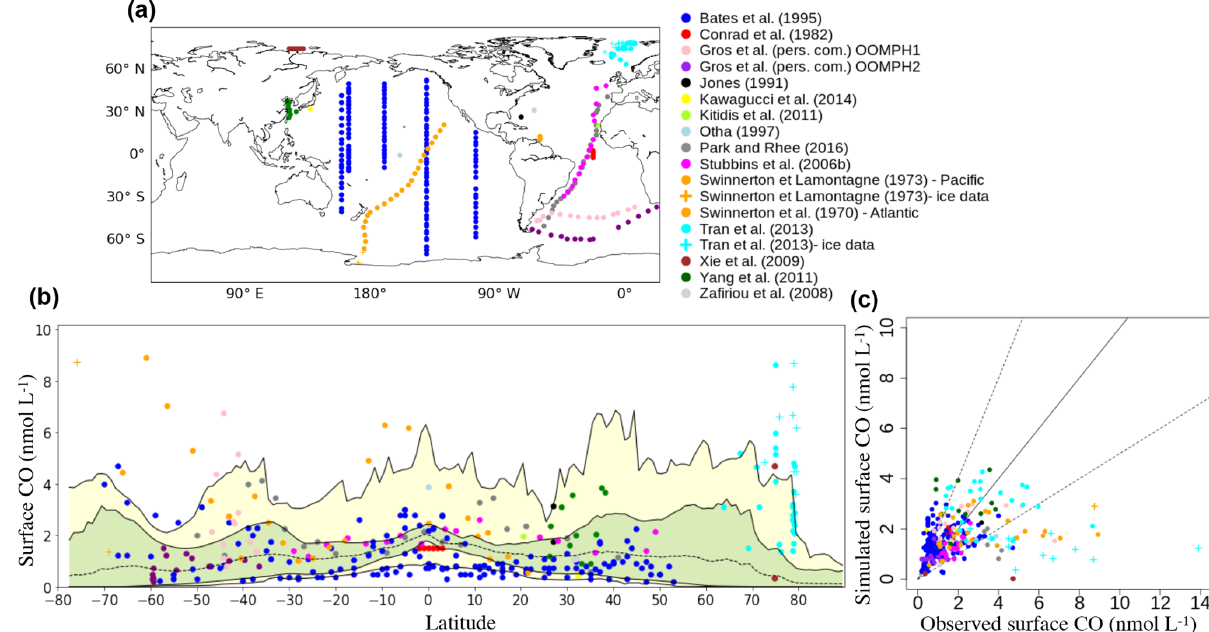
Figure 6. Comparison of in situ oceanic CO concentrations between 0 and 10m simulated with PISCES with those measured in the surface ocean. (a) Position of the surface measurements collected in the literature. (b) Surface CO concentrations as a function of the latitude (Dots: observed concentrations; dotted line: longitudinal and monthly mean simulated CO concentration; green area: interval between maximum and minimum longitudinal mean concentrations; yellow area: interval between maximum and minimum CO concentrations at a given latitude). Note that a data point of 13.9nmolL − 1 from the dataset of Tran et al. (2013) has been removed for better visibility. (c) Scatter plot the of the simulated CO surface concentrations vs. the observed concentrations. The solid line represents the 1–1 line and dotted lines the 2–1 and 2–1